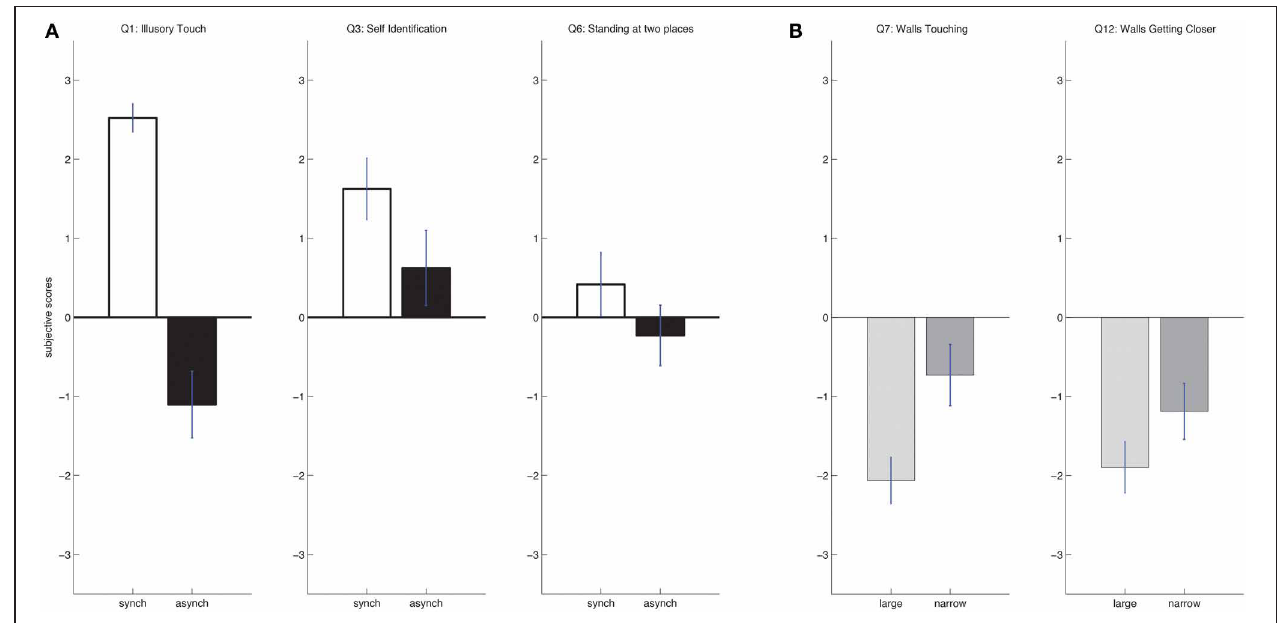
FIGURE 3 | Subjective responses. (A) Bodily self-consciousness. Results of the questionnaire responses are shown (mean and standard error) for the items that depended on stroking (questions 1 and 3). (B) Architectonic